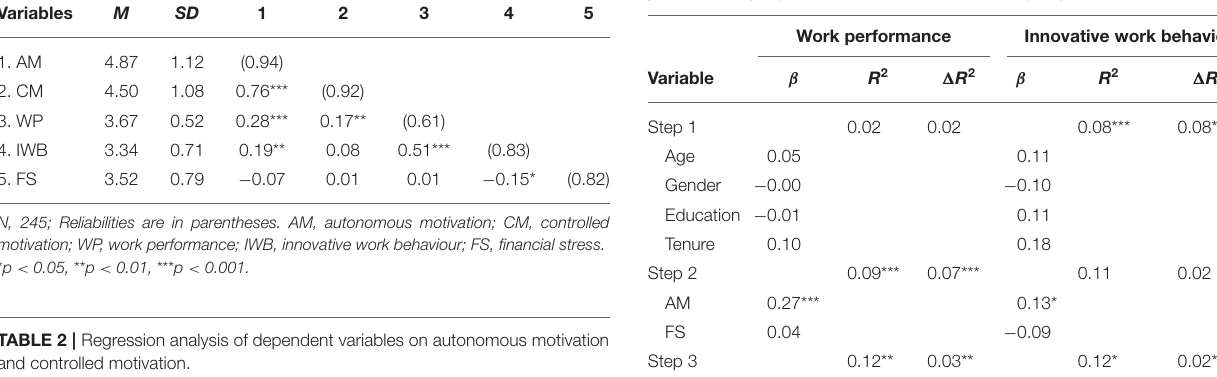
TABLE 2 | Regression analysis of dependent variables on autonomous motivation and controlled motivation. Variable